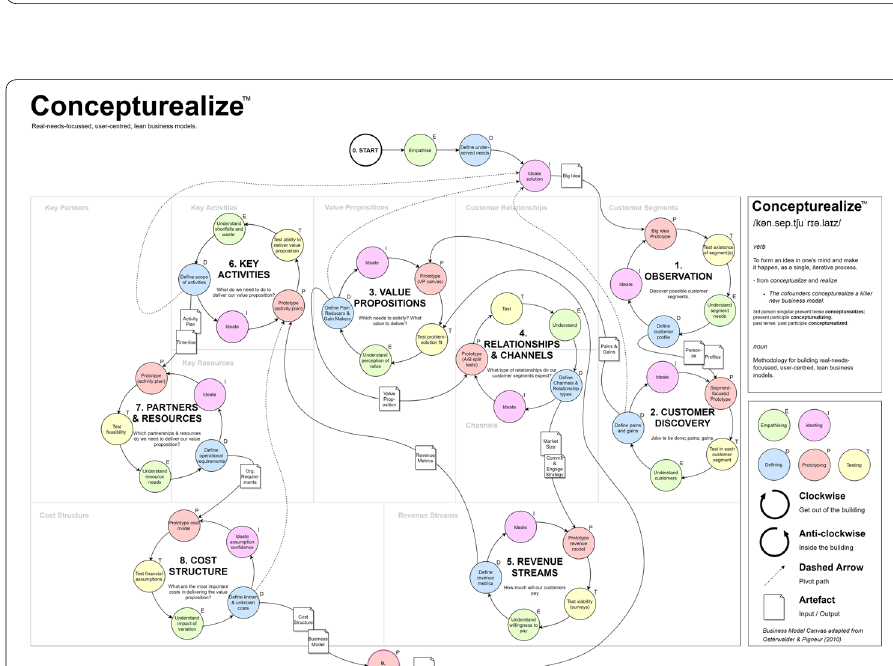
Fig. 7 Concepturealize ™ methodology, illustrated with business model canvas overlay based on Osterwalder and Pigneur (2010, p.